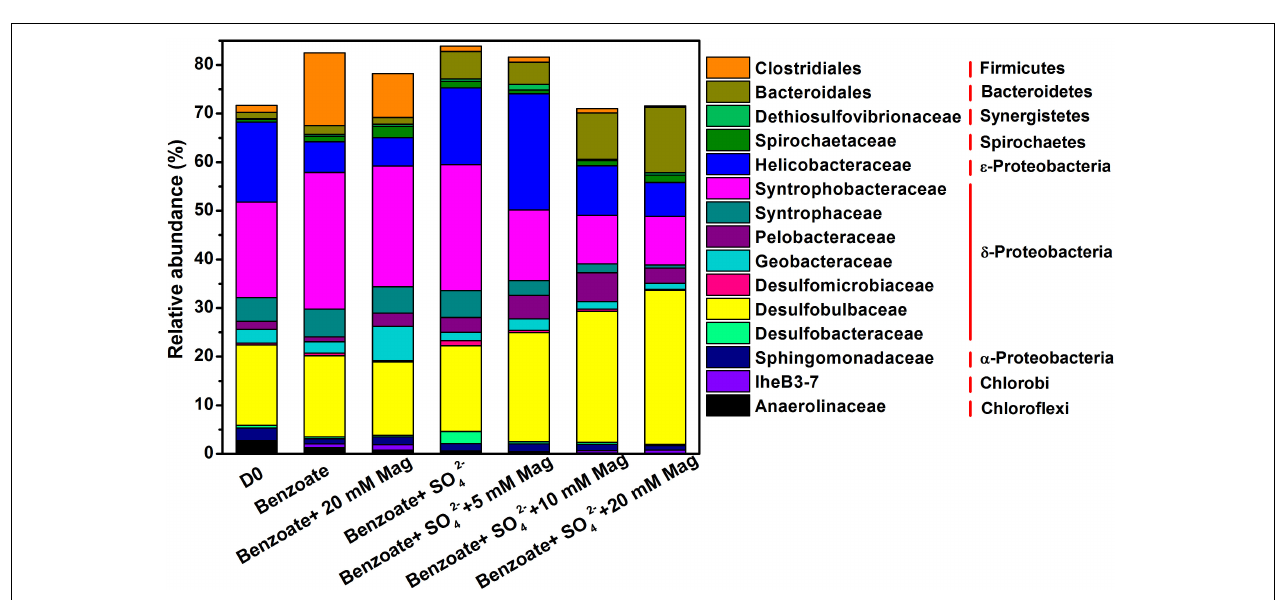
FIGURE 4 | Comparison of the rates of benzoate degradation and sulfate reduction with different iron oxides [NTA-Fe(III), magnetite and hematite]. The different lowercase letters denote significant difference between the four treatments. Mag, Hem, and Fe-NTA denote magnetite, hematite and ferric nitrilotriacetate, respectively.